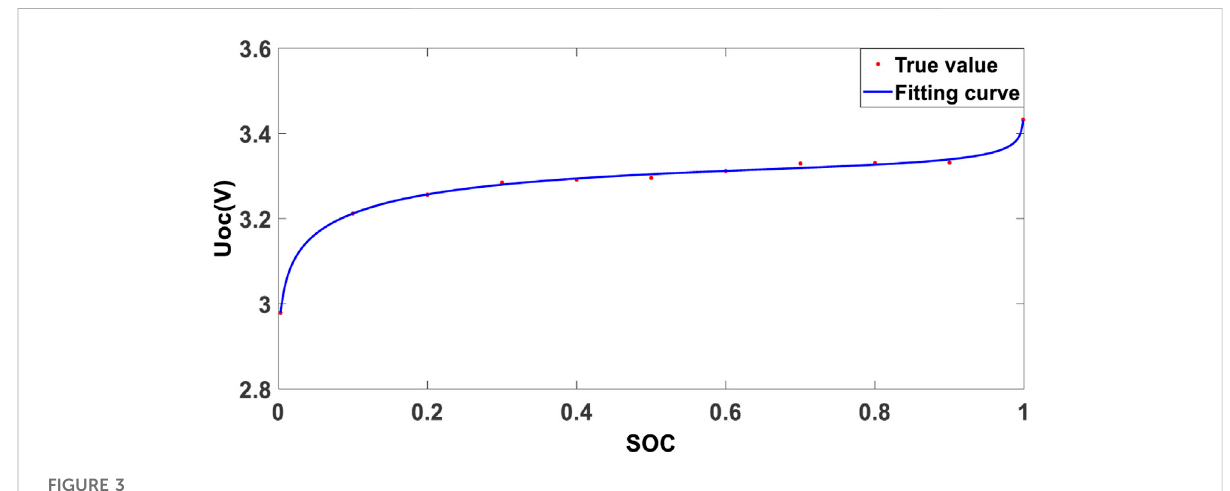
FIGURE 3 Open circuit voltage and SOC fi